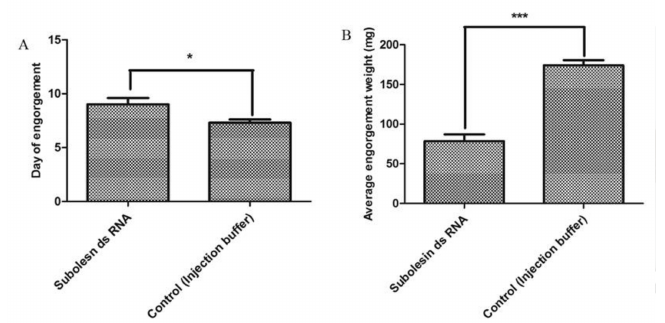
Figure 4. Knockdown effects of subolesin ds RNA on tick engorgement and reproduction. ( A ) Average day of engorgement, and ( B ) data of average engorgement weight between subolesin ds RNA and the control group injected with injection buffer. The asterisk (*) denotes a significant difference compared with the control group as determined by a Student’s t -test (* p < 0.015; *** p < 0.0001).